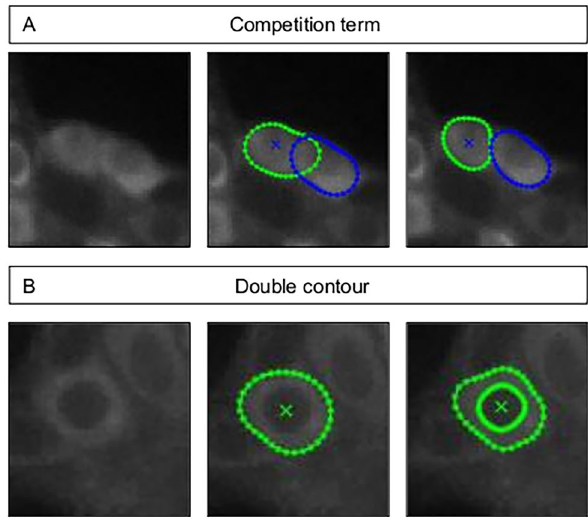
Figure 3. The effect of a competition term on neighboring contours (top) The contour of a cell using 1-layer vs double contour in a GCaMP expressing neuron